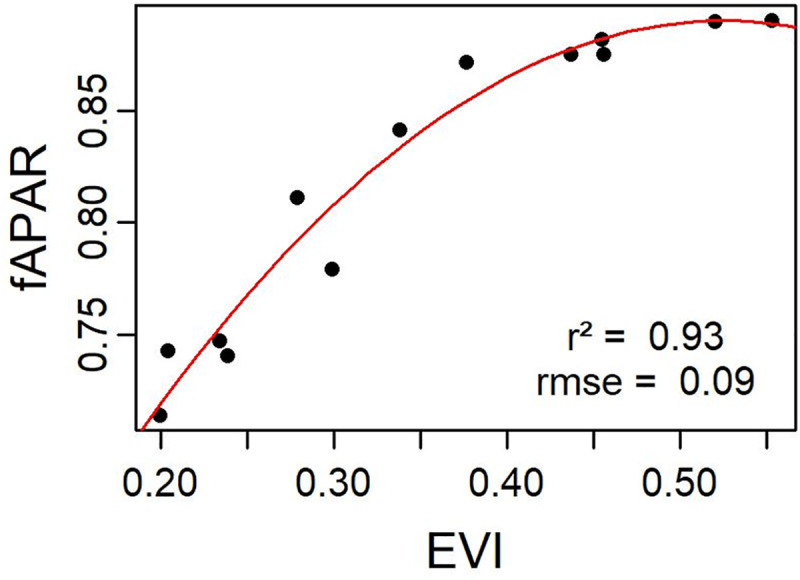
Relationship between half-monthly fAPAR and EVI.The red line is the quadratic regression line fitted to the cloud of points. The resulting equation is: fAPAR = -1.62 * EVI2 + 1.70 * EVI + 0.44.